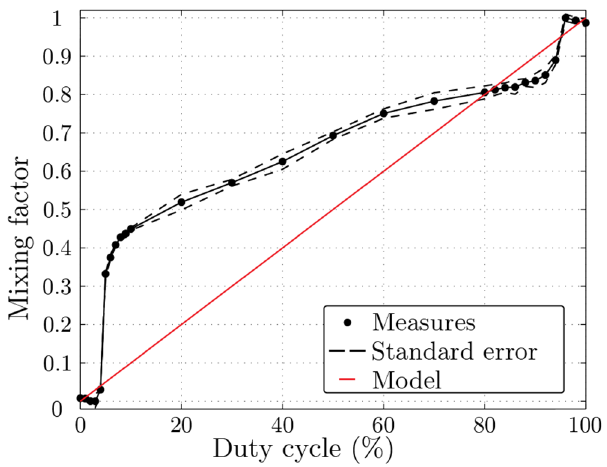
Fig 6. Gas chromatography measures of mixing factor K as a function of duty cycle α . Graph shows average and standard error of mixing factor K gas chromatography measures as a function of duty cycle α